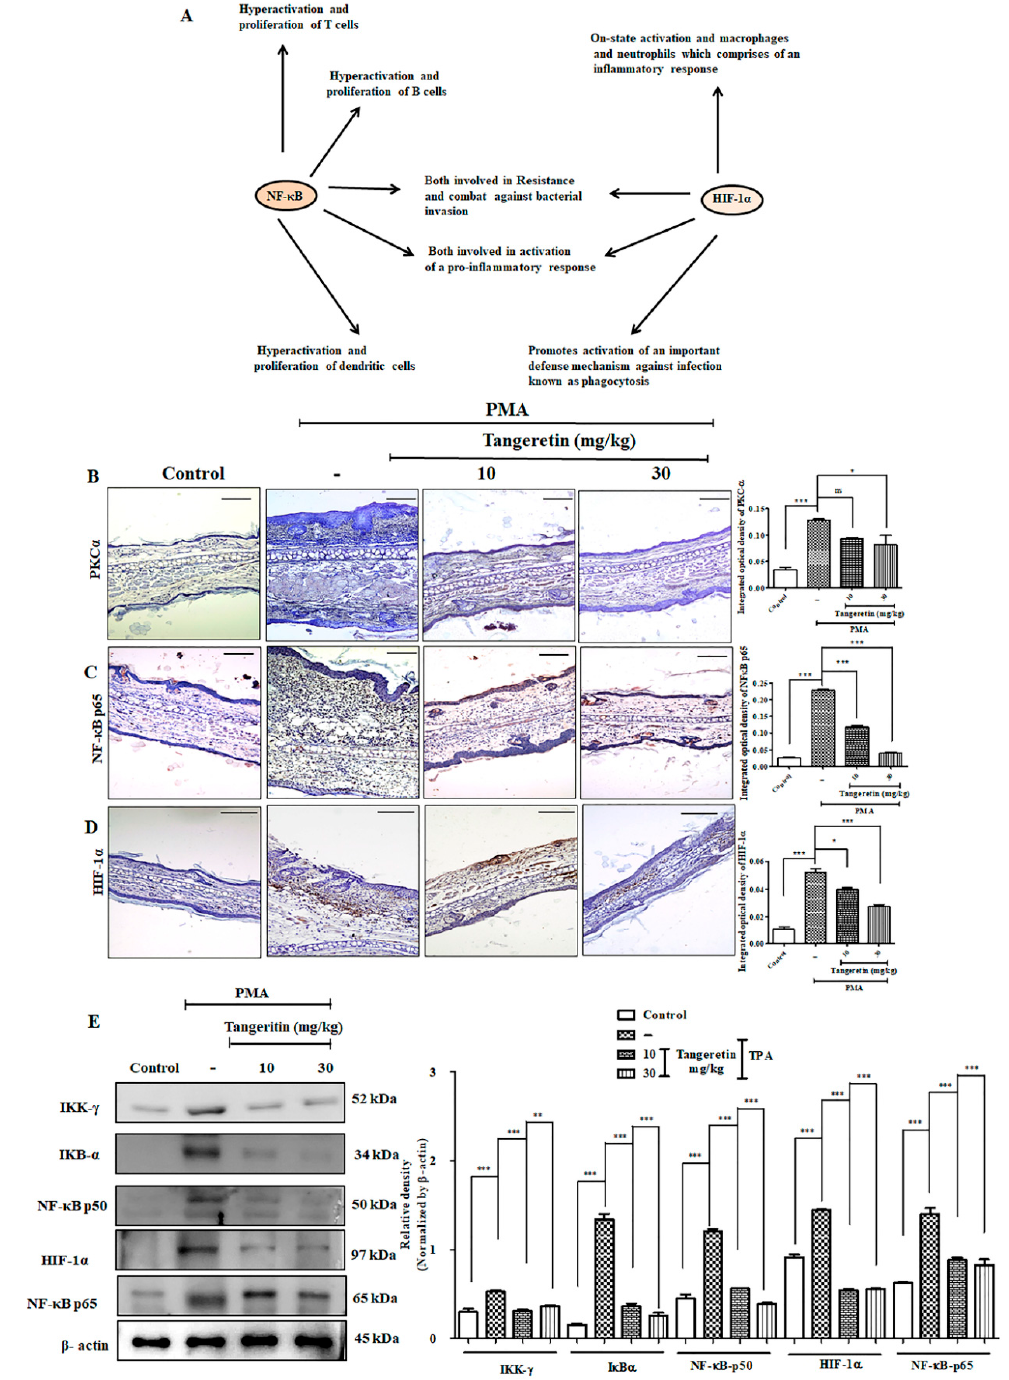
Figure 8. TAN blocks PMA induced hypoxia-inducible factor 1-alpha (HIF-1 α ) and nuclear factor kappa-light-chain-enhancer of activated b cells (NF- κ B) inflammatory crosstalk. ( A ) Concept building diagram representing the interaction and crosstalk between HIF-1 α and NF- κ B after PMA challenge on mice ears, ( B ) PKC α expression on mice ear tissues evaluated by immunohistochemical analysis, ( C ) NF- κ B-p65 levels evaluated by immunohistochemical analysis, ( D ) HIF-1 α evaluated by immunohistochemical analysis, ( E ) Western blotting analysis cytoplasmic HIF-1 α and NF- κ B pathway markers evaluated from ear tissue homogenates. Scale bar (100 µ M). Magnification = 200 × . Statistical significance analysis was carried out through a one-way analysis of variance (ANOVA) prism. * p < 0.05, ** p < 0.01, *** p < 0.001 and ns (non-significant).